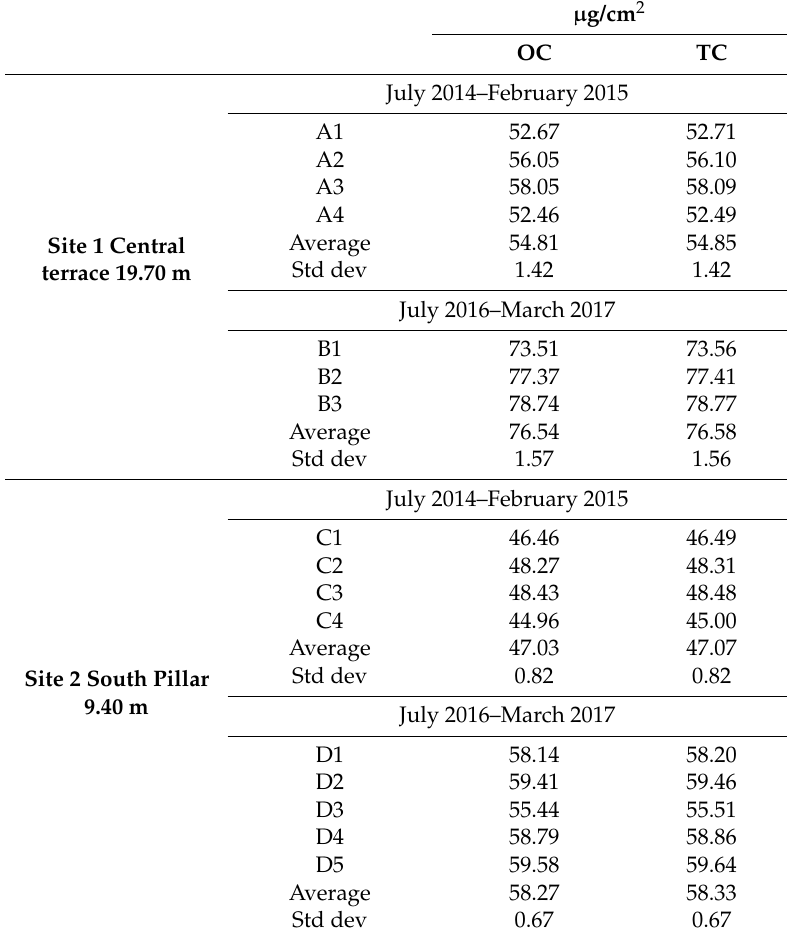
Table 4. OC (organic carbon) and TC (total carbon) determined on quartz fiber filters and powder deposits exposed in the two sites on the Duomo façade during the two